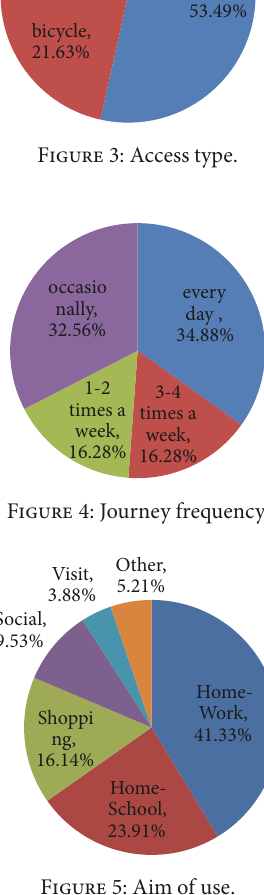
Figure 5: Aim of